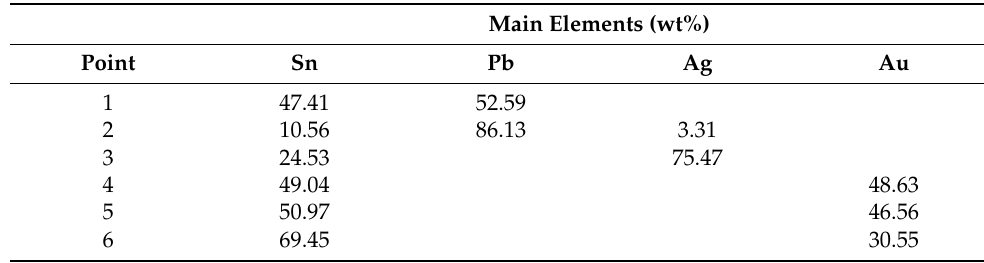
Figure 5. The averaged PBD-signal amplitude along the line in the SEM micrograph of area near the solder joint of the Ge−solder−AlN structure. Triangles are for experimental data. Blue curves are fitting. The element composition in the marked points on the red line is given in Table 1. Adapted with permission from [63]. Copyright (2019), Elsevier. Table 1. Data of the EDS analysis corresponding to Figure 5. Adopted with permission from [63]. Copyright (2019),